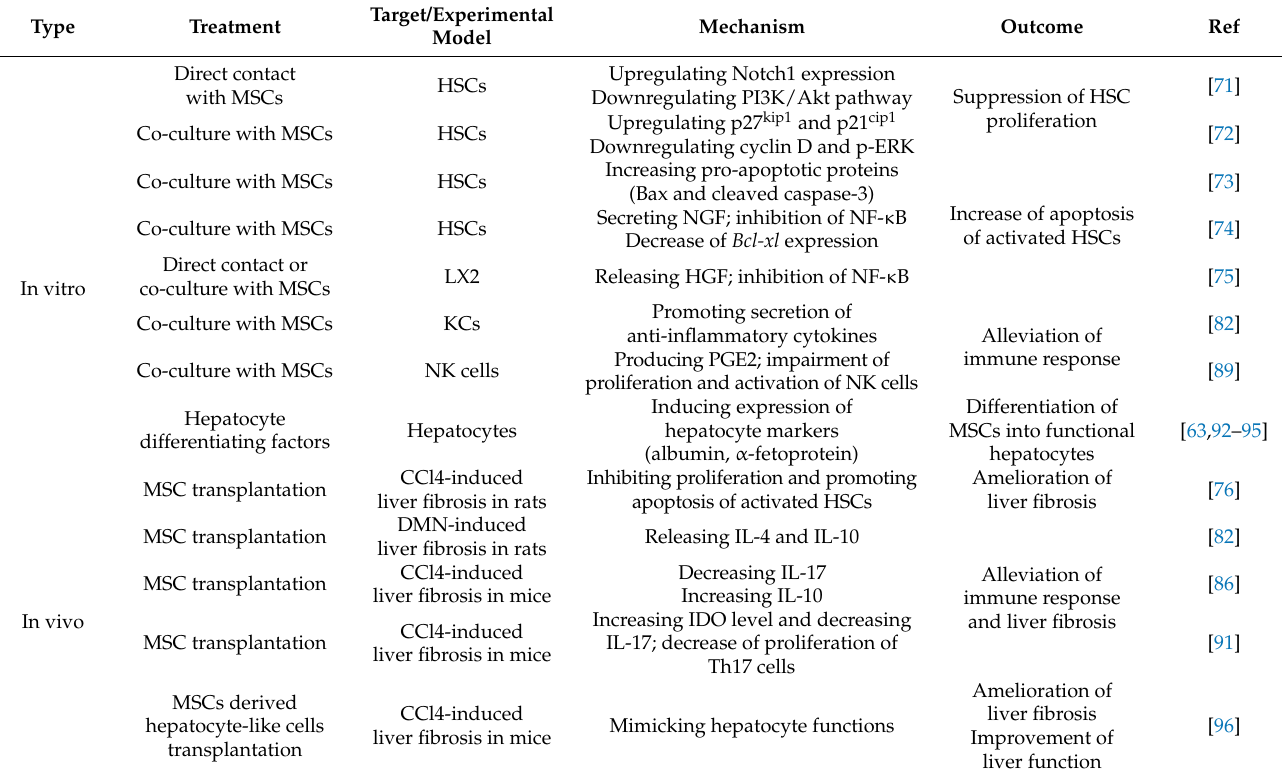
Table 1. Summary of MSC administration for liver